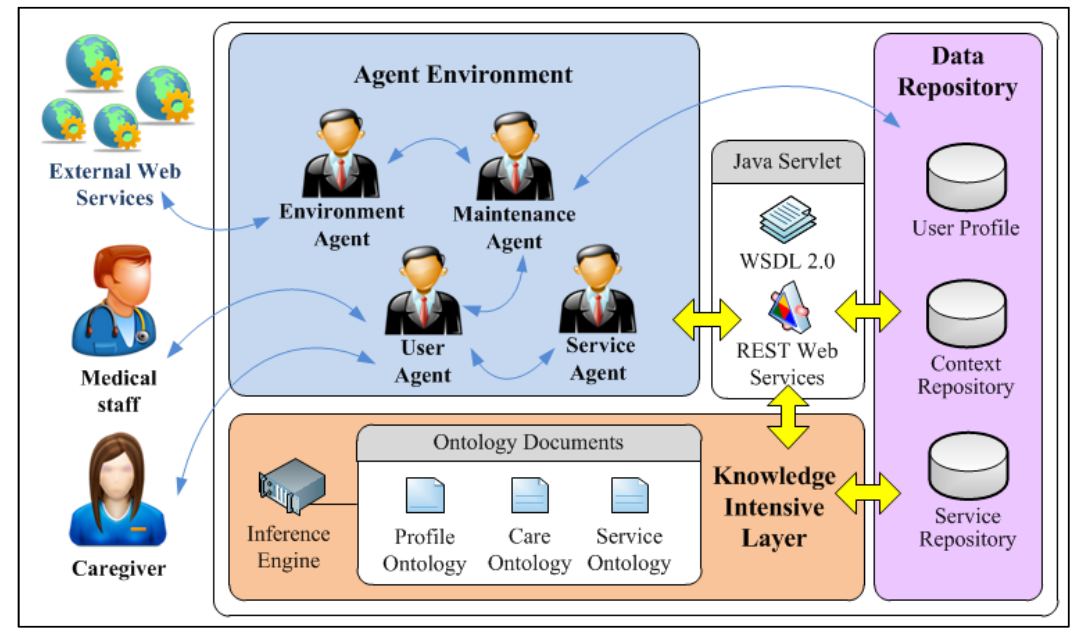
Figure 2. The IAServ